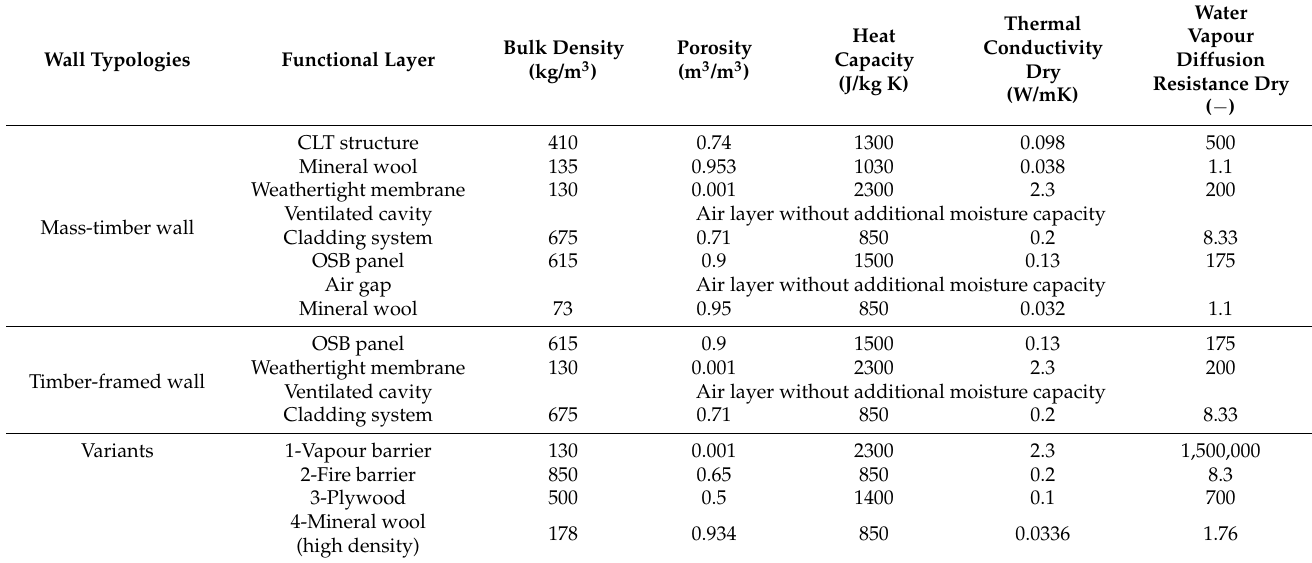
Table 3. Material properties of the wall layers for each